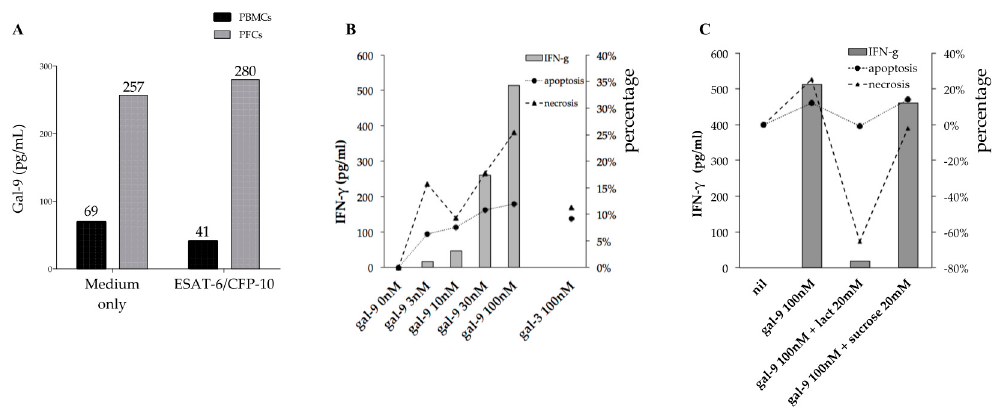
Figure 5. IFN- γ secretion, apoptosis, and necrosis in unstimulated PFC cultures treated with Gal-9. ( A ) Gal-9 levels in supernatants of PBMC and PFC cultures stimulated or not with ESAT-6/CFP-10; ( B ) Dose-dependent effect of Gal-9 on PFC cultures; ( C ) Effect of Gal-9 antagonist lactose on Gal-9 stimulation of PFCs (sucrose was used as control).